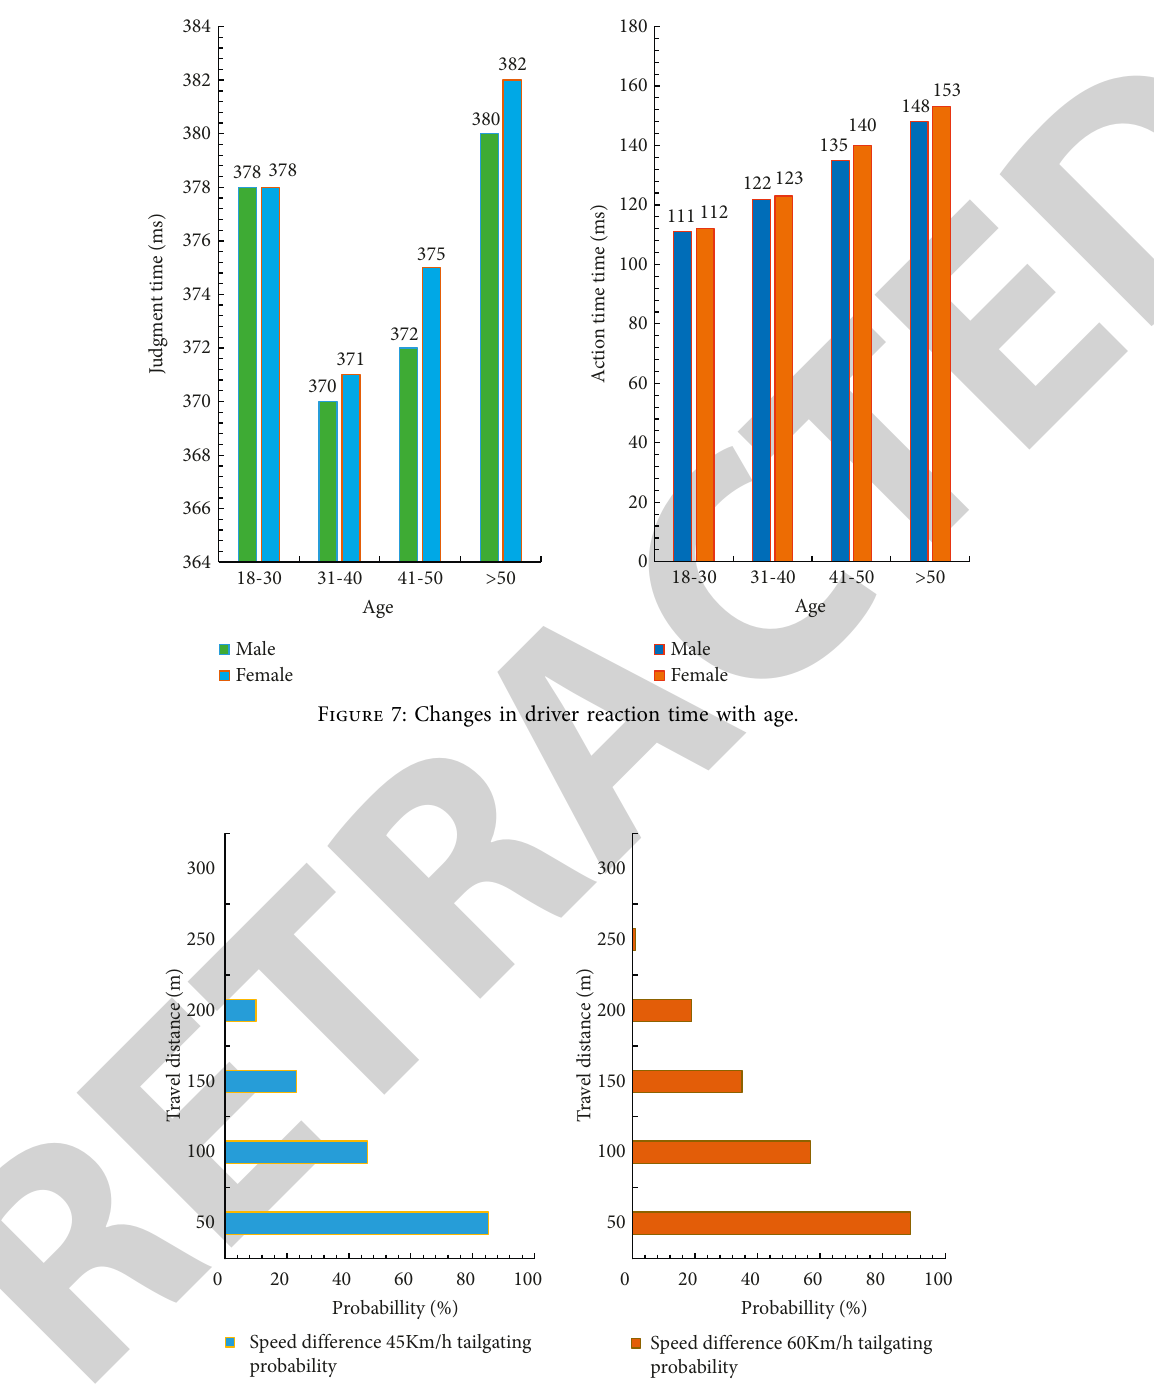
Figure 8: Crash probability of vehicles with different speed differences at different workshop